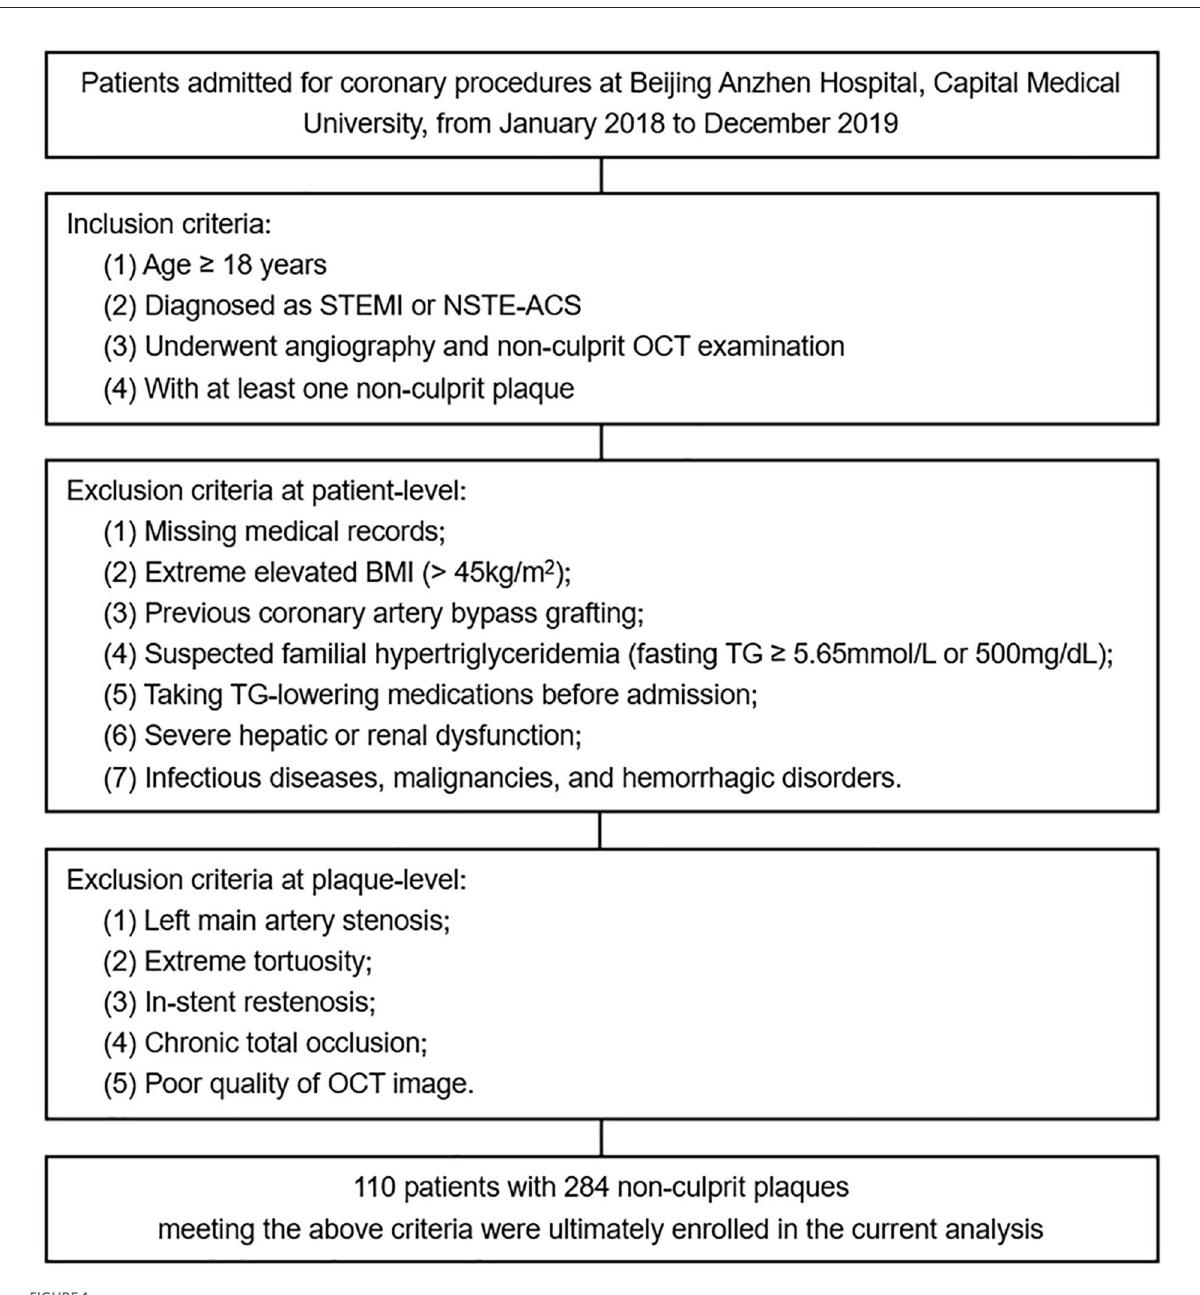
was inputted into an established electronic database by two independent personnel who were ignorant of the study